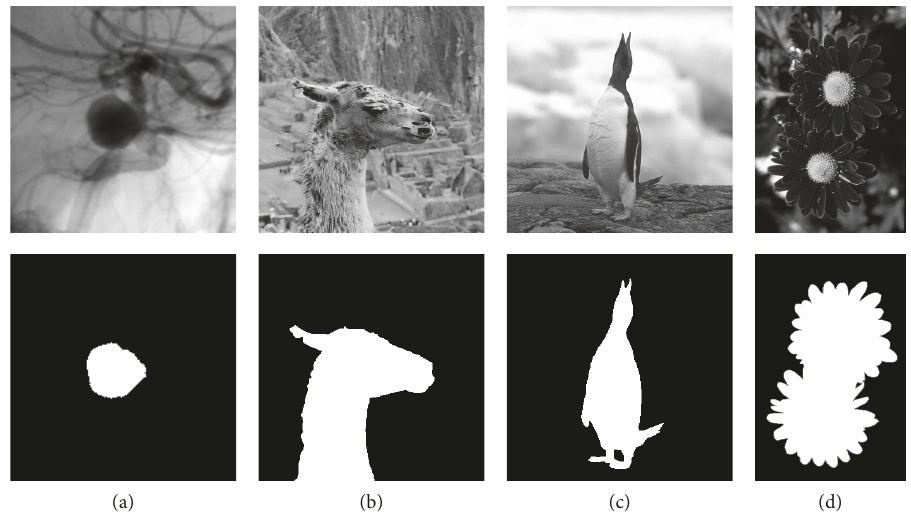
Figure 7: In the top row, image data utilized in the usability tests are depicted. In the bottom row, the ground truth segmentations of the images are illustrated. The image of a contrast enhanced aneurysm (a) and its ground truth annotation by a medical expert were composed for this study. Images (b)–(d) are selected from the GrabCut image database initially created for